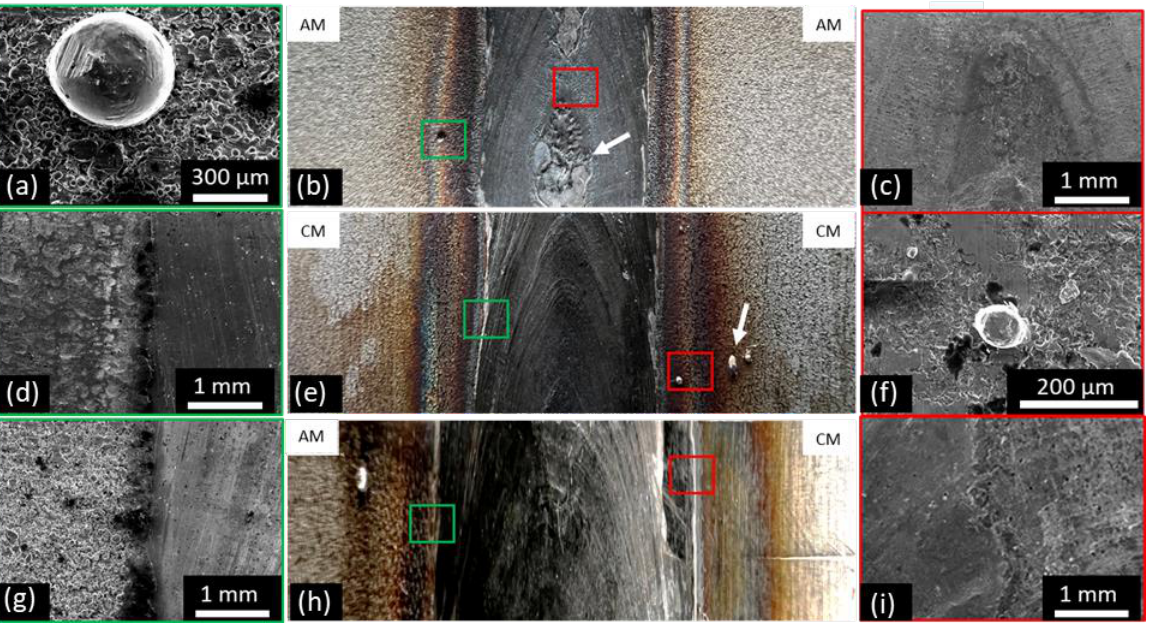
Figure 10. Welded joint macro and micrography: ( a-f ) spatters, ( b ) AM-AM, ( c ) AM-AM fusion zone, ( d-i ) HAZ CM side, ( e ) CM-CM, ( h ) CM-AM.